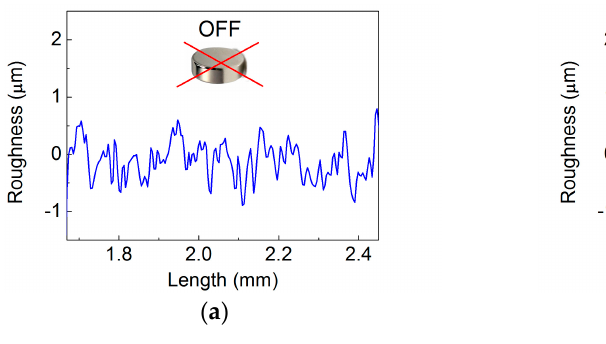
Figure 11. Representative ( a , b ) 2D height profiles and ( c , d ) 3D surface topography images of the MRE sheet containing bare CI particles at ( left ) the off ‐ state and ( right ) in the presence of the external magnetic field.